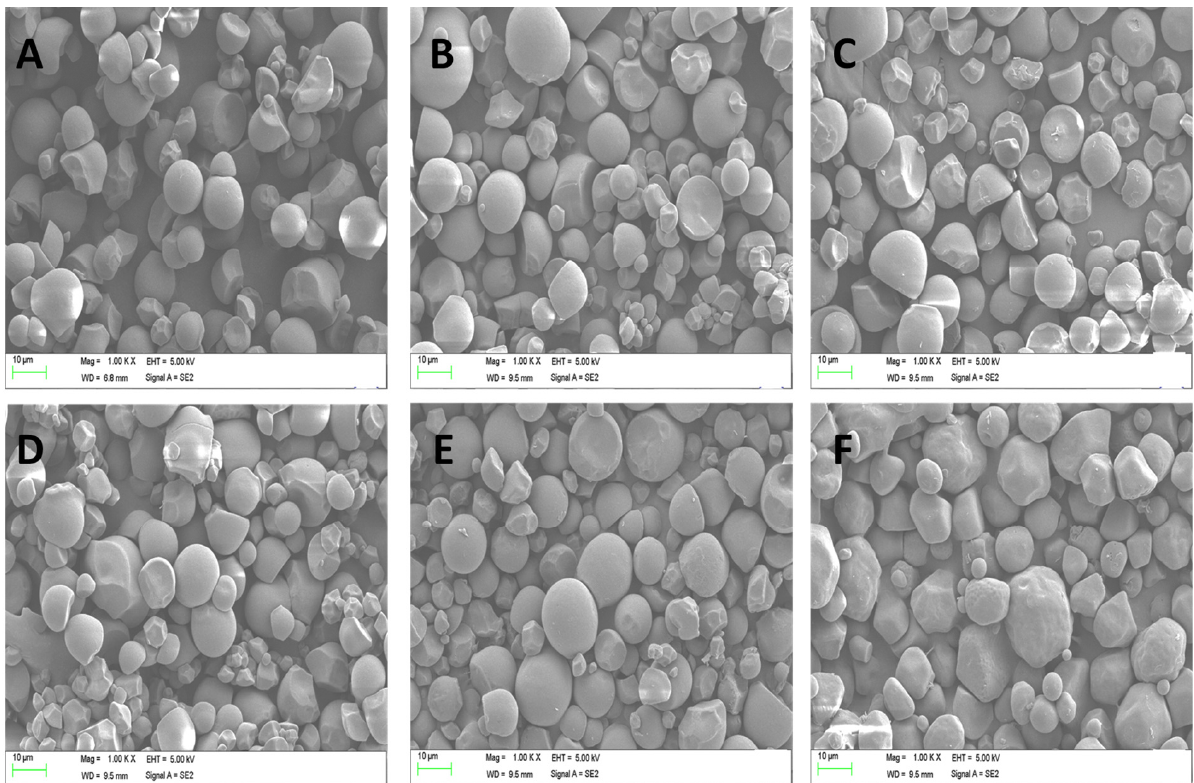
Figure 2. Scanning electron micrographs of OSA-modified high-amylose PMS (Kudzu) starch samples, ( A ) native, ( B ) Un-2% OSA, ( C ) 24 h H-2% OSA starch, ( D ) 24 h H-4% OSA starch, ( E ) 24 h H-6% OSA starch, and ( F ) 24 h H-8% OSA starch.